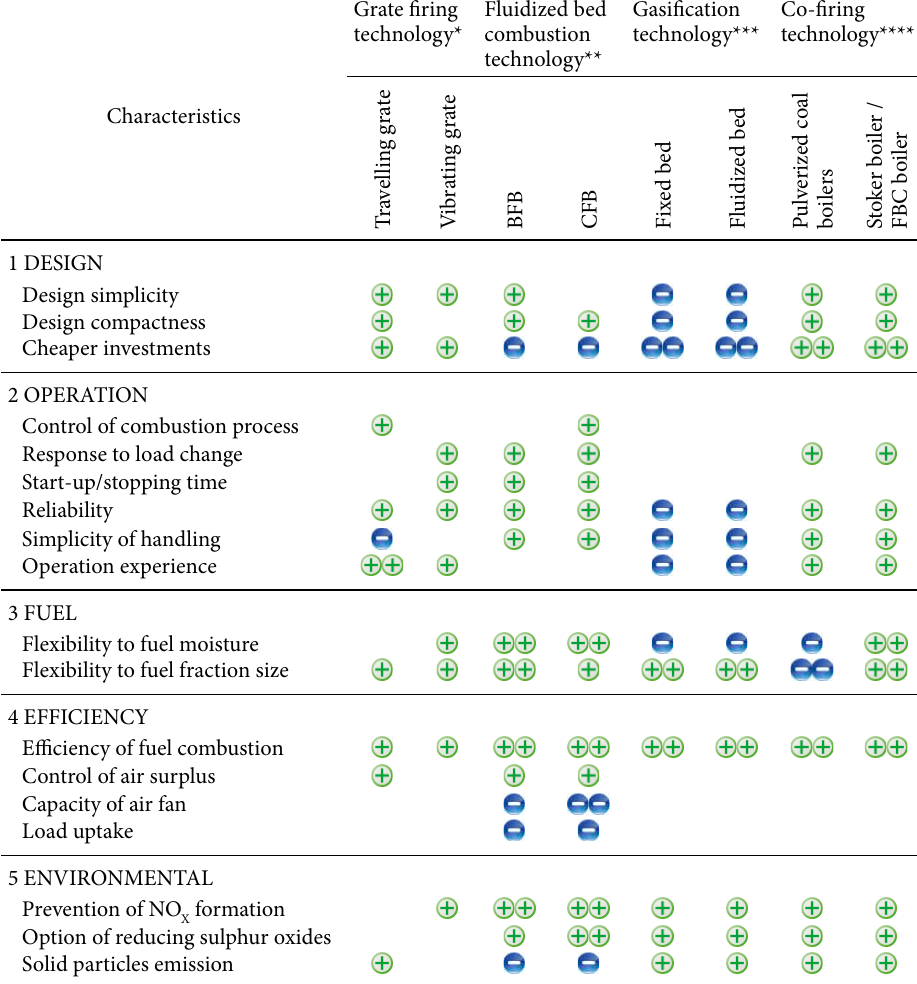
Table 5. Juxtaposition of woody biomass conversion